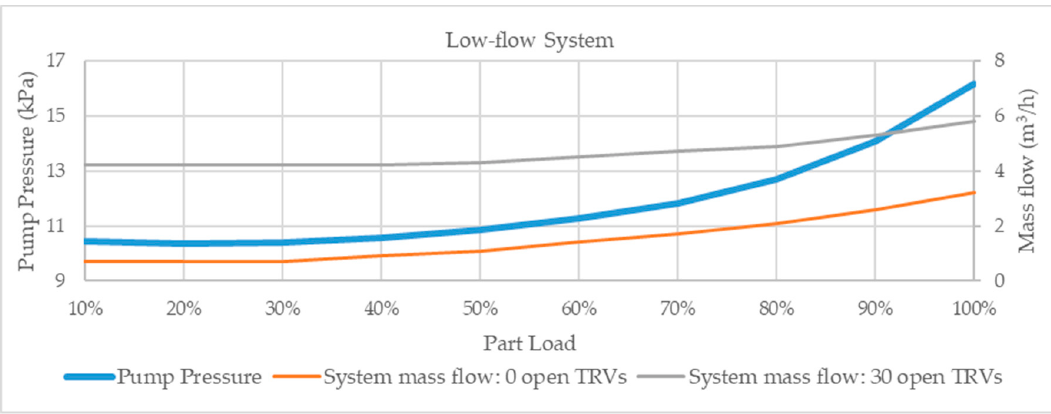
Figure 7. The calculated optimal supply temperature and the return temperature results from the analysis for the operation without problematic thermostatic radiator valves (TRVs) and with one problematic TRV in each riser under low-flow system operation. Energies 2019 , 12 , 3215 14 of 24